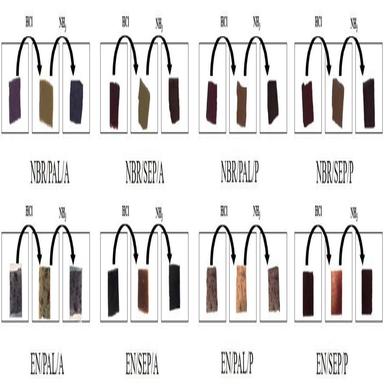
Digital photographs of the polymer composite samples filled with organic–inorganic pH indicators before and after 24 h of exposure to HCl or NH3.